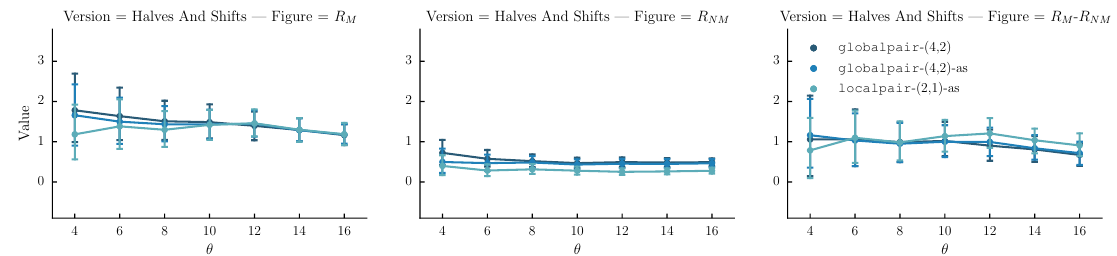
Figure 7. The average relative likelihood R M (first column) that the different motif instances are